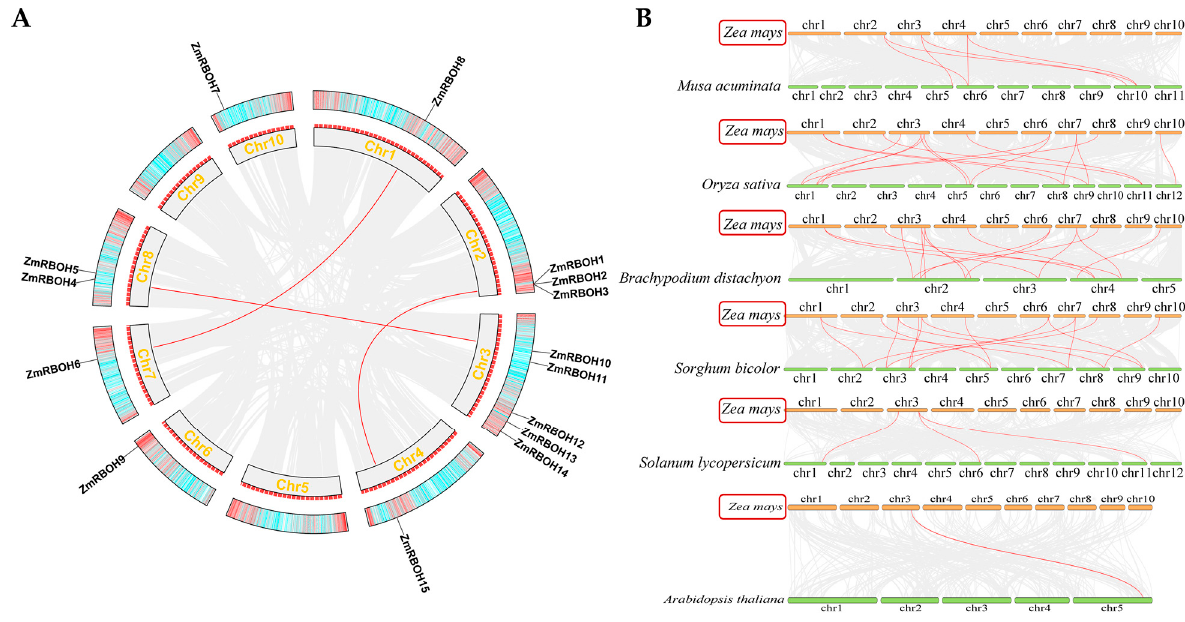
Figure 4. Syntenic analysis of RBOH genes. ( A ) Syntenic analysis of RBOHs and orthologous gene pairs in maize. The chromosomes are depicted as a circle. The red curves denote the syntenic regions of the ZmRBOH genes. Each maize chromosome was attached with 300-kb gene density information depicted by the heatmap. ( B ) The synteny of RBOH members between maize and six other species. The syntenic blocks are set as the gray background, and the syntenic RBOH members ae highlighted with red curves.